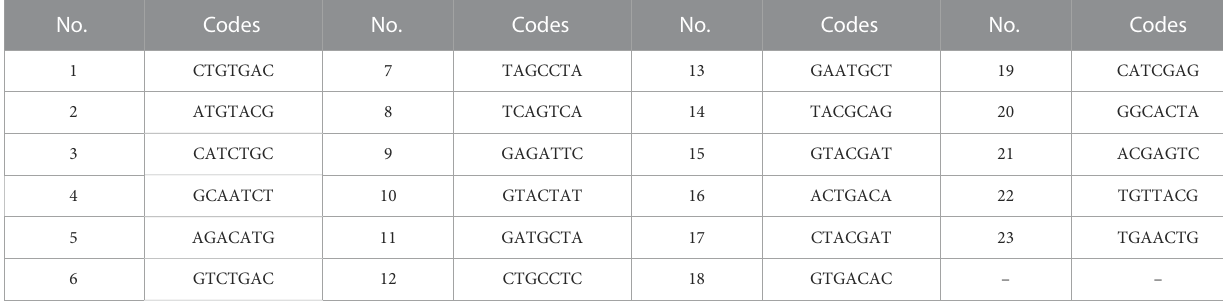
TABLE 5 DNA coding sets received at n (cid:2) 7 ,d (cid:2) 5 from Table 4. No.